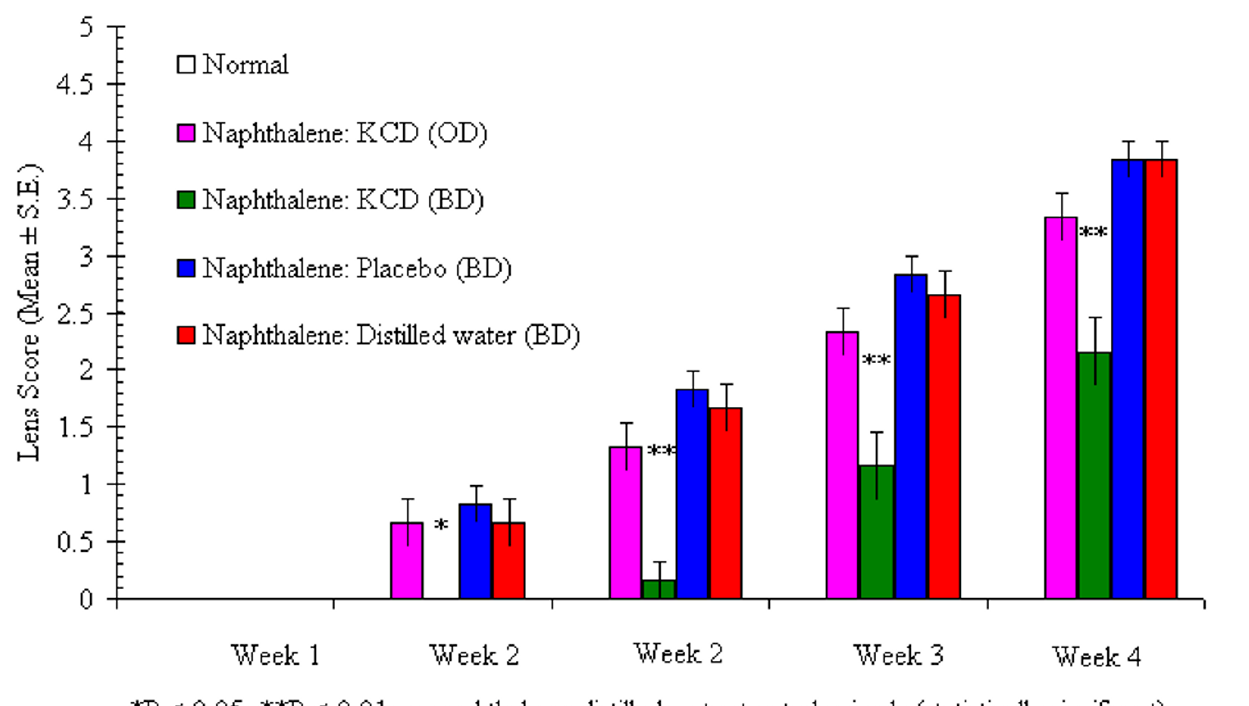
Figure 1 Effect of Kohl-Chikni Dawa eye drops on naphthalene-induced cataract in